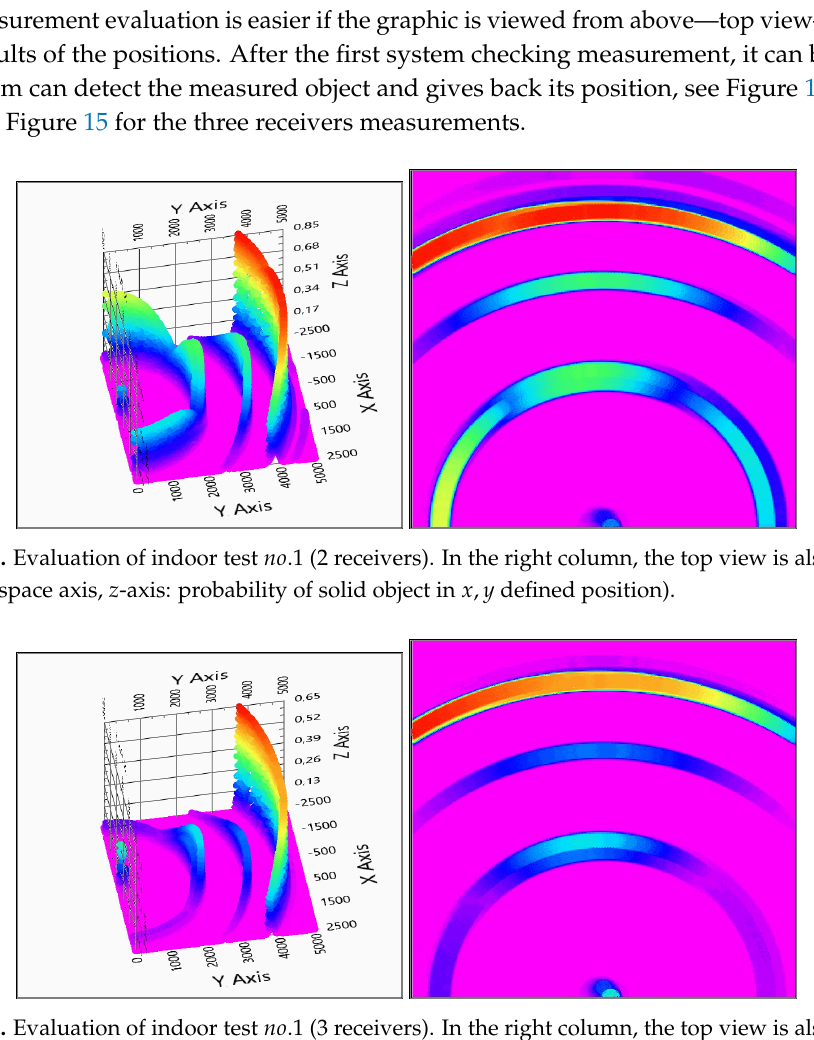
Figure 15. Evaluation of indoor test no .1 (3 receivers). In the right column, the top view is also shown ( x , y : x , y space axis, z -axis: probability of solid object in an x , y defined